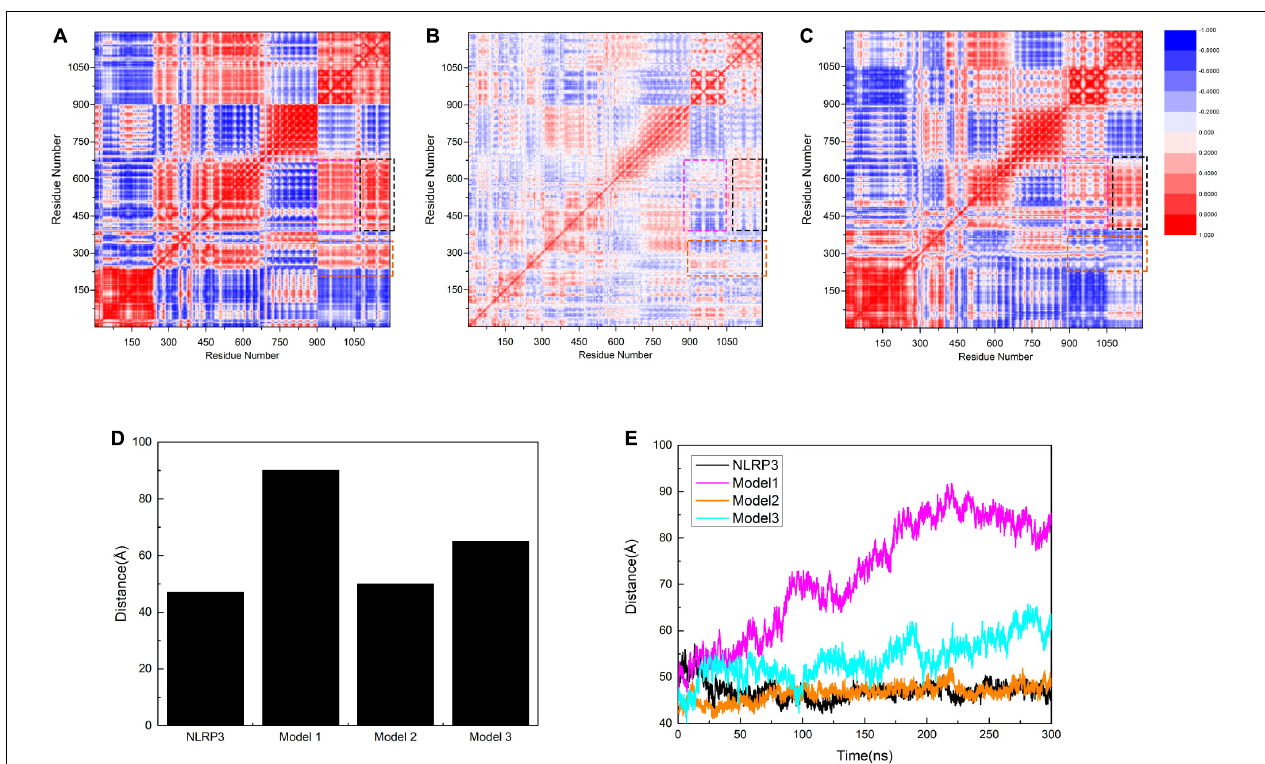
FIGURE 6 | Correlation factor analysis results for 1,050 residues of (A) Model 1, (B) Model 2, and (C) Model 3. The black rectangle shows HD2 (residues 535–697 of NLRP3) and part of LRR (residues 698–832 of NLRP3) in relation to C-TXNIP (residues 154–299 of TXNIP). The magenta rectangle indicates HD2 and part of LRR corresponding to N-TXNIP (residues 8–147 of TXNIP). The orange rectangle presents HD1 (residues 360–438 of NLRP3) and part of WHD (residues 439–493 of NLRP3) corresponding to TXNIP. Residues with strong and weak correlations are represented in red and blue, respectively. The legend for the degree of correlation is presented on the right side. (D) The maximal distance (Å) between residues L338 and G779 in NLRP3 alone, Model 1, Model 2, and Model 3. (E) Distance curves (Å) between residues L338 and G779 in NLRP3 alone (black), Model 1 (magenta), Model 2 (orange), and Model 3 (cyan) after simulation at 0, 50, 100, 200, 250, and 300 ns.